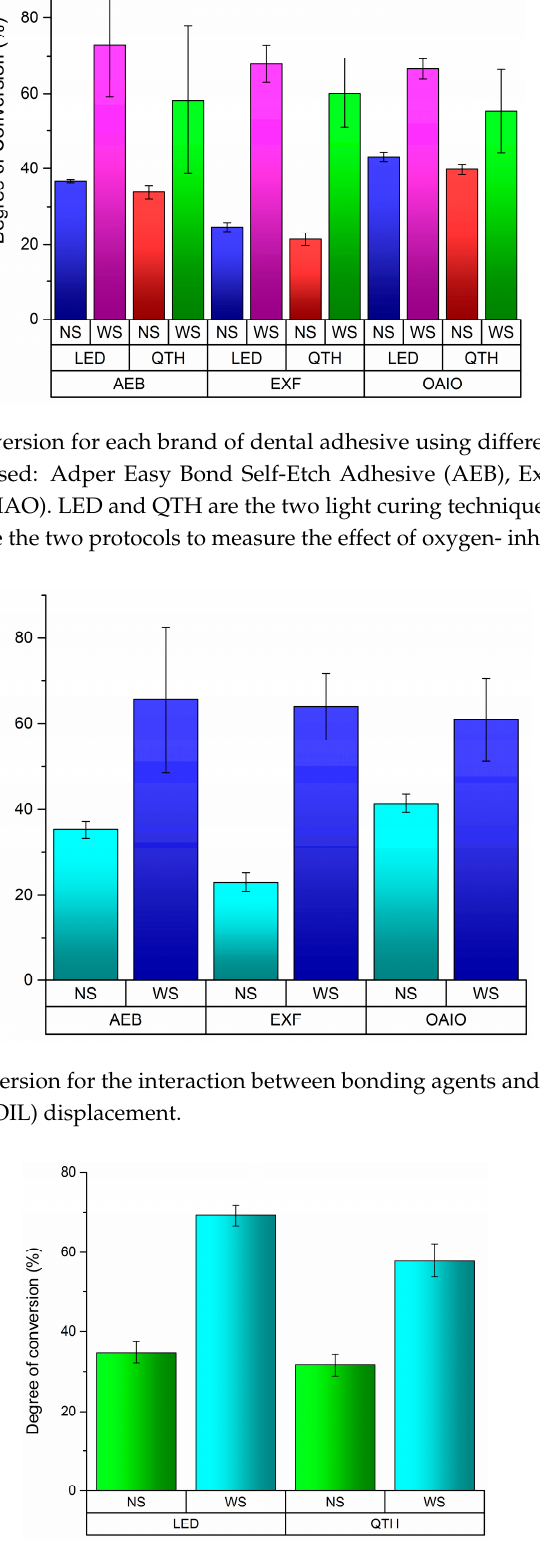
Figure 3. Means and standard deviation (SD) of the degree of conversion for the interaction between light curing and protocol of OIL